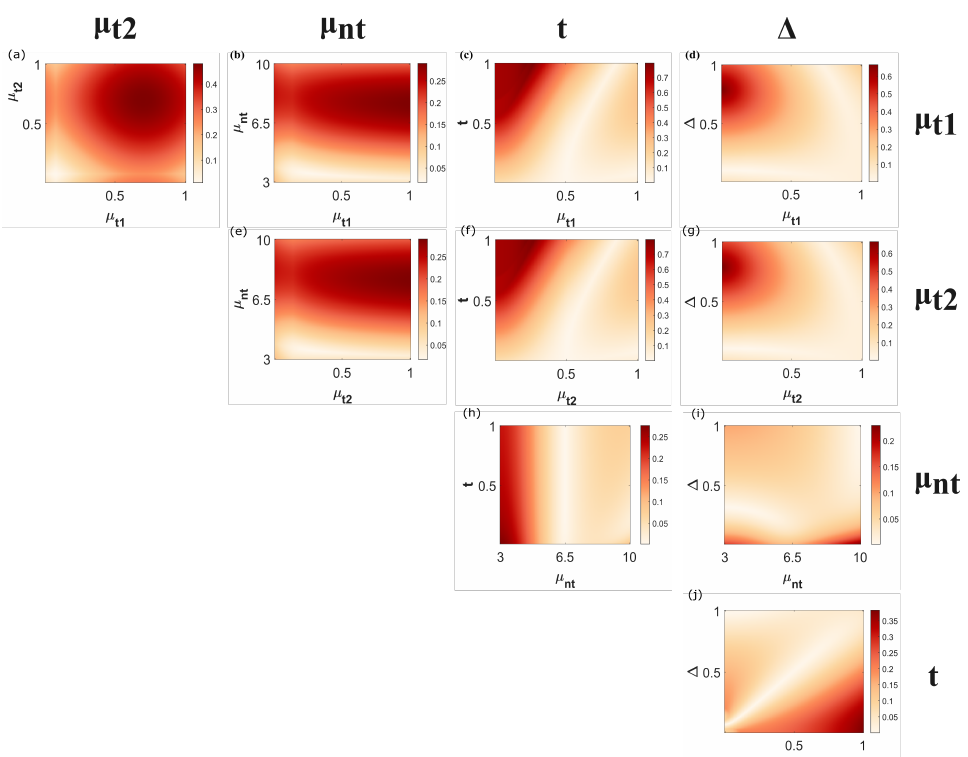
− E µ Figure 12: E | , µ , µ , t and ∆ . Colormap | 00 〉 is a function of parameters 11 〉 t1 t2 nt − E showing dependence of E | | 00 〉 on a pair of parameters in each sub-figure (keep- 11 〉 ing others fixed). The fixed parameters in the sub-figures for N = 10 site Kitaev chain = 4; n = 7 are as follows. (a), t = 1, ∆ = 0.5, with non-topological segment: n nt 1 nt 2 µ = 5. (b), µ = 0.1, t = 1, ∆ = 0.5. (c), µ = 0.1, µ = 5, ∆ = 0.5. (d), nt t2 t2 nt µ = 0.1, µ = 5, ∆ = 0.5. (e), µ = 0.1, t = 1, ∆ = 0.5. (f), µ = 0.1, µ = t2 nt t1 t1 nt